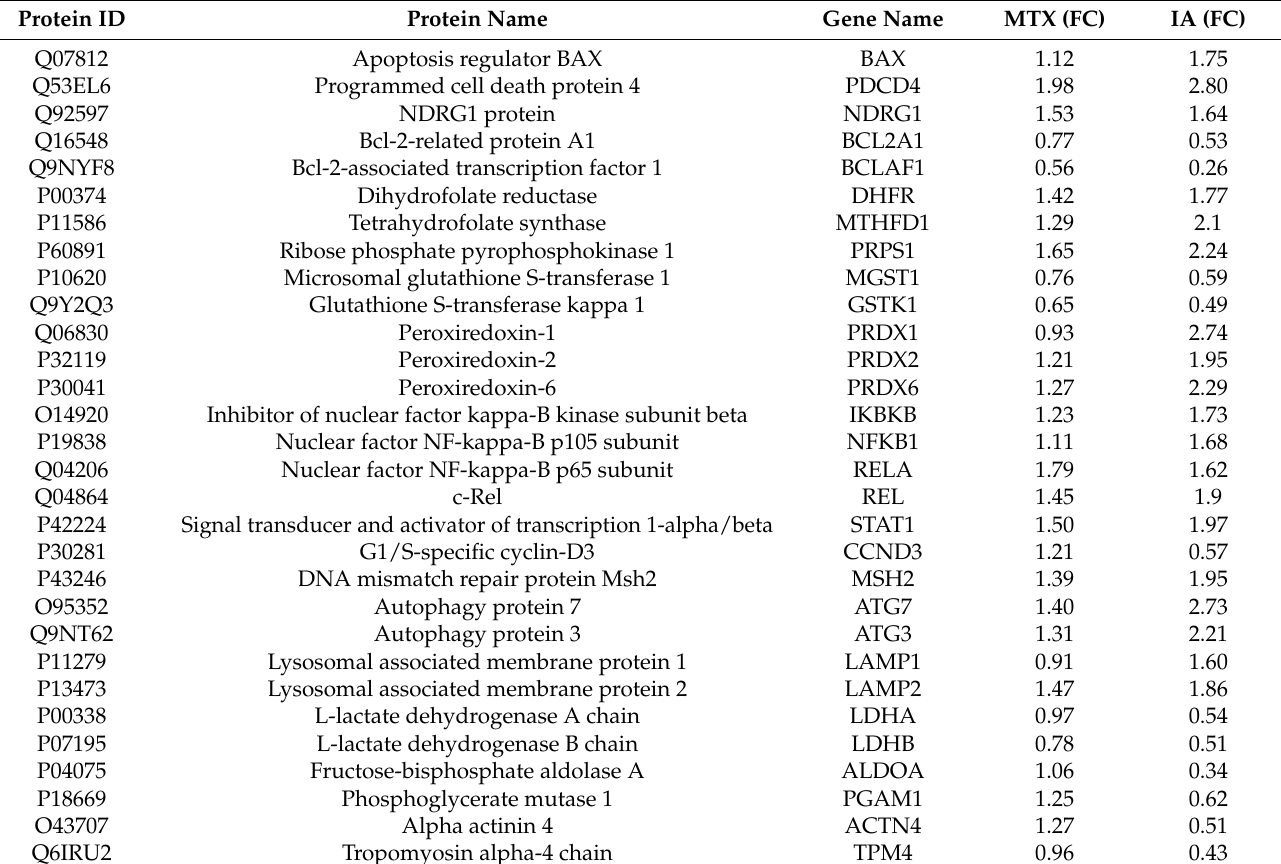
Table 2. Protein expression dysregulation involved in U-937 cell death induced by incomptine A ( IA ) and identified by iTRAQ. Fold change (FC) values are shown for all identified key proteins for each